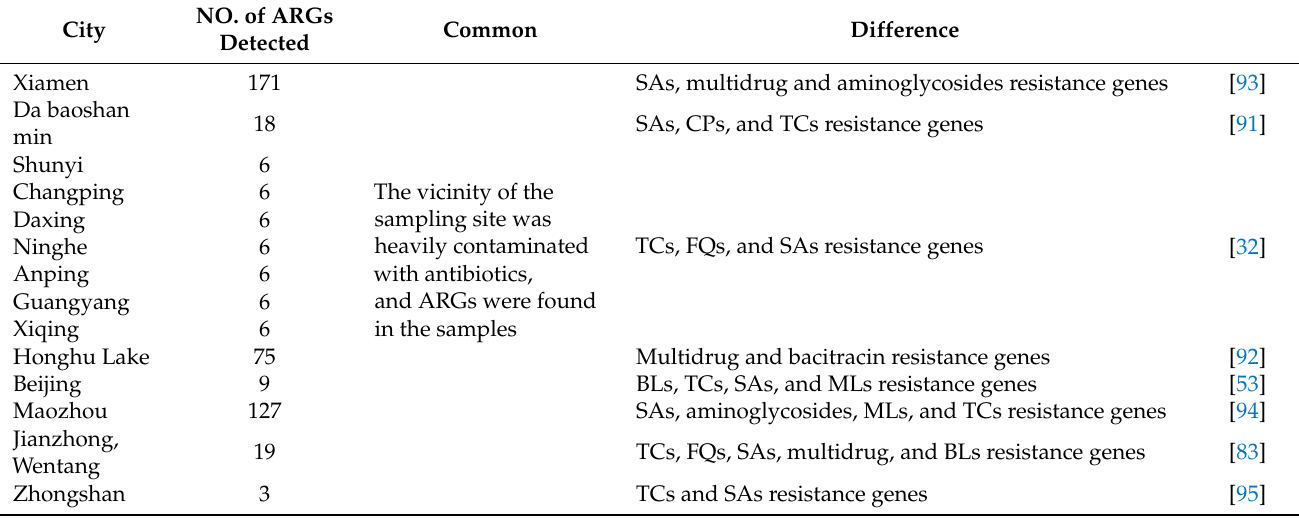
Table 5. Occurrence of ARGs in groundwater of